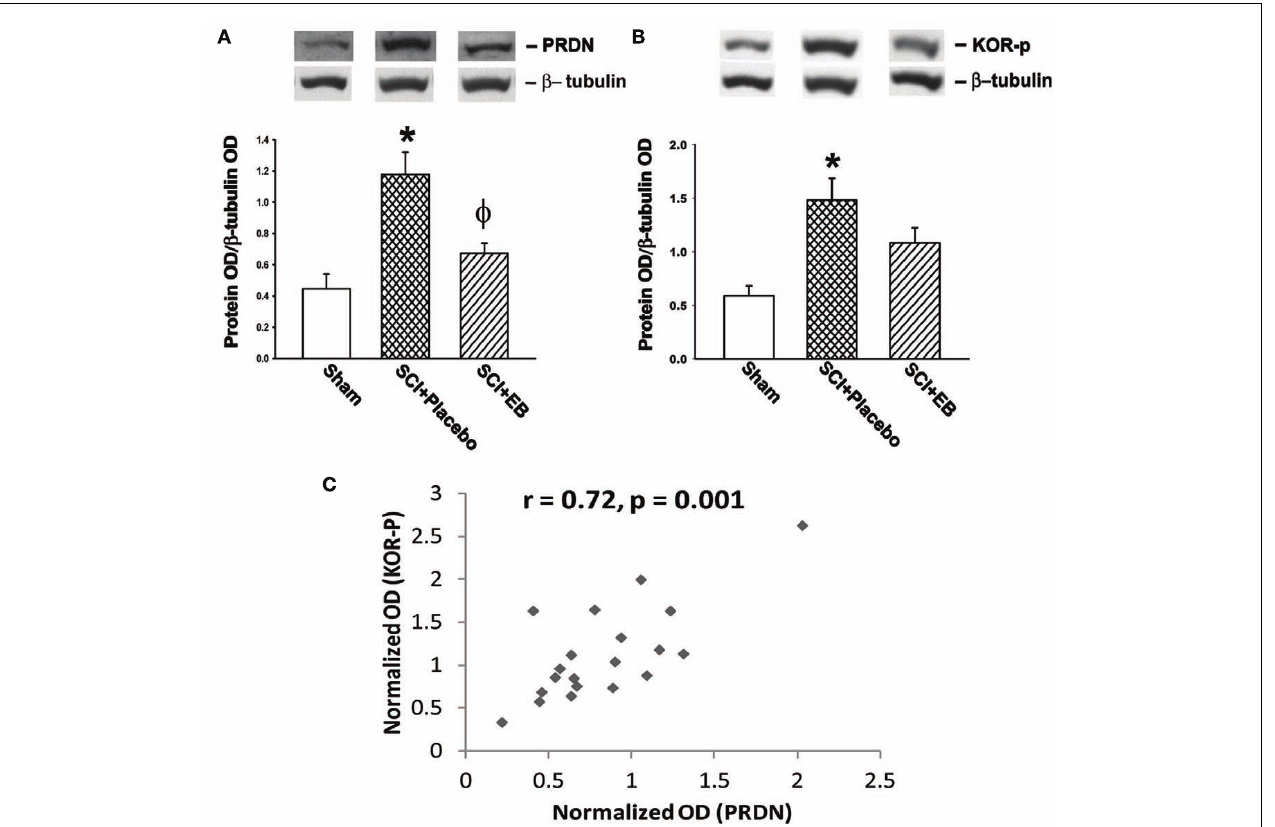
(* p < 0.01).The KOR-P levels after EB treatment were not found to be significantly different from those in either the sham or the placebo-treated group. (C) Depicts the presence of a positive correlation between the normalized OD (optical density) units representing the tissue levels of PRDN and KOR-P in the at level spinal cord.The total OD units of PRDN and KOR-P bands were normalized after division with the respective OD levels of β -tubulin (50kDa band). All data are represented as mean ± SEM of the normalized OD values, and were analyzed by ANOVA. n = 4, Sham; n = 8, SCI + placebo; n = 7, SCI +